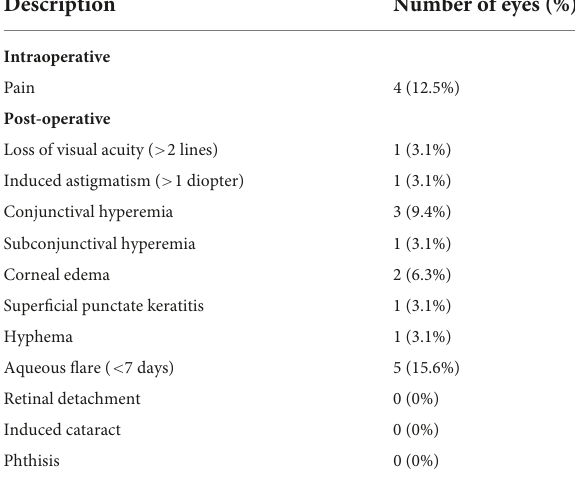
TABLE 3 Intra-operative and post-operative